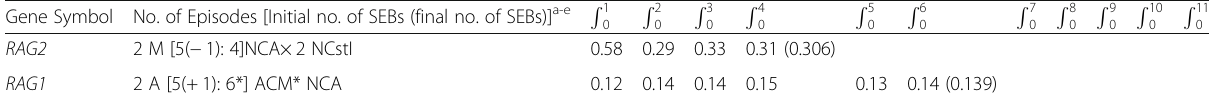
Table 12 Chromosome 11 ( − ) strand chromatin VDJ recombinase gene, RAG2, and (+) strand chromatin VDJ recombinase gene, RAG1 , sequential esebssiwaagoT Q s to final 2-digit (and 3-digit) esebssiwaagoT Q Gene Symbol No. of Episodes [Initial no. of SEBs (final no. of SEBs)] a-e